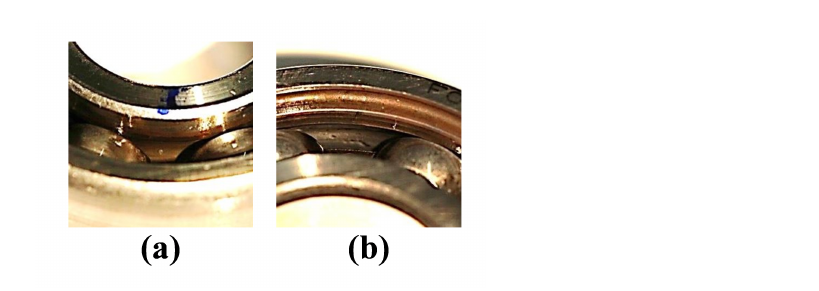
Figure 12. Modular test rig of Paderborn.